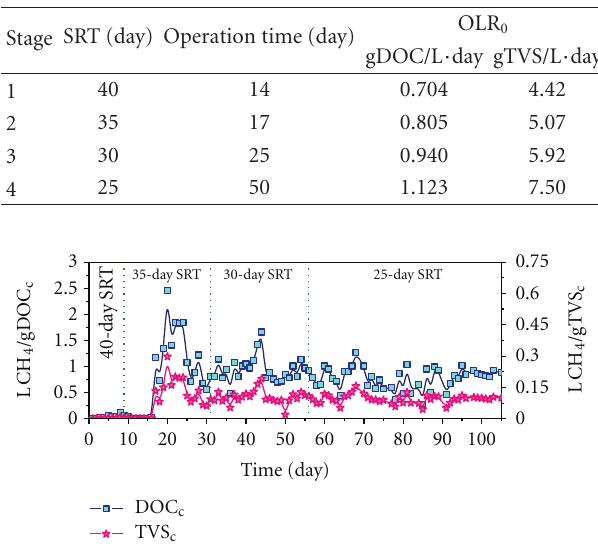
Figure 3: Evolution of the specific methane yield expressed as LCH 4 /gDOC c and LCH 4 /gTVS c .